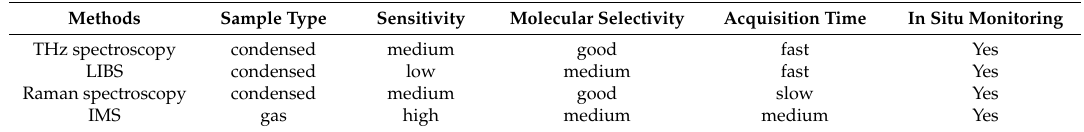
Table 4. Comparison of the four spectroscopic detection